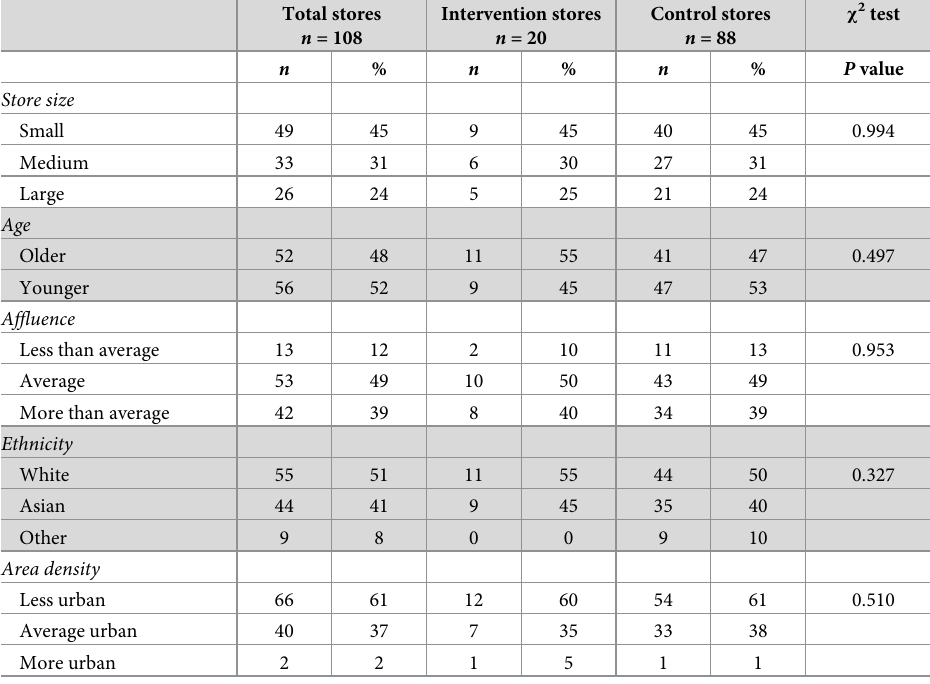
Table 1. Demographic store characteristics relating to the surrounding population. Total